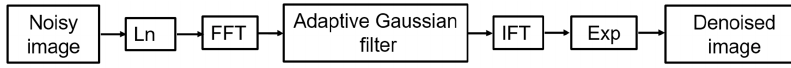
Figure 4. The proposed adaptive homomorphic system.